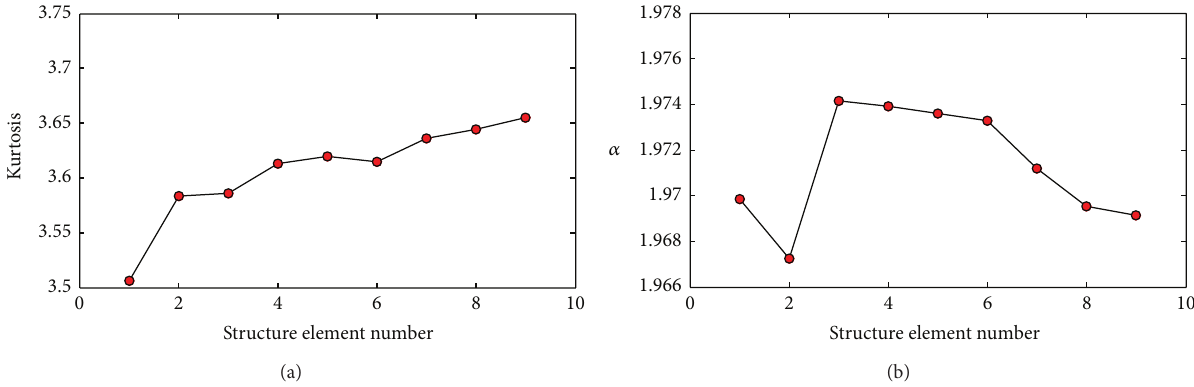
Figure 15: (a) Kurtosis value versus length of SE for 131,072 samples; (b) 𝛼 value versus length of SE for 131,072 samples.